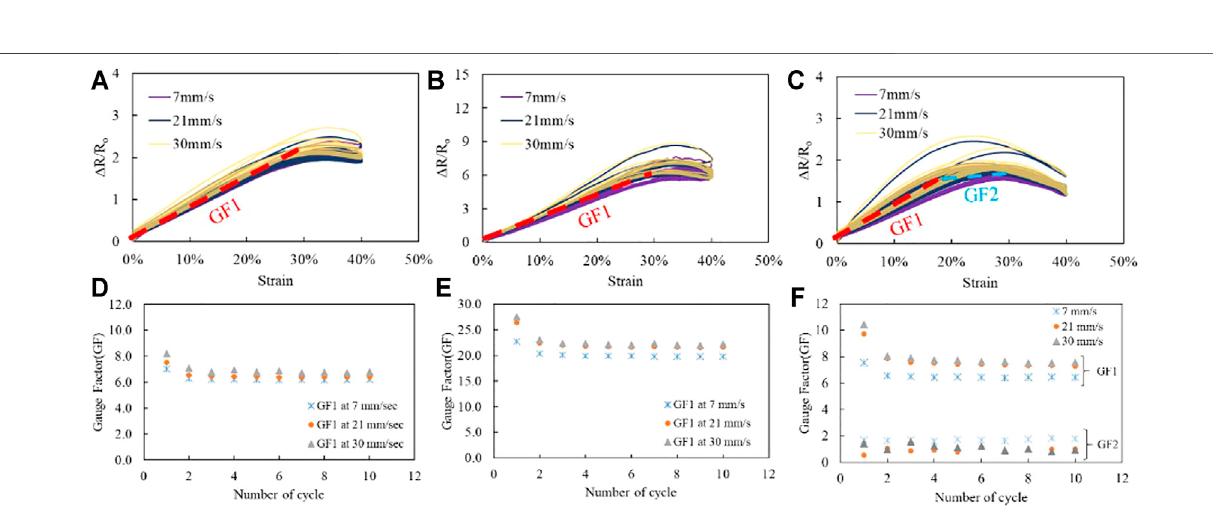
Frontiers in Robotics and AI |